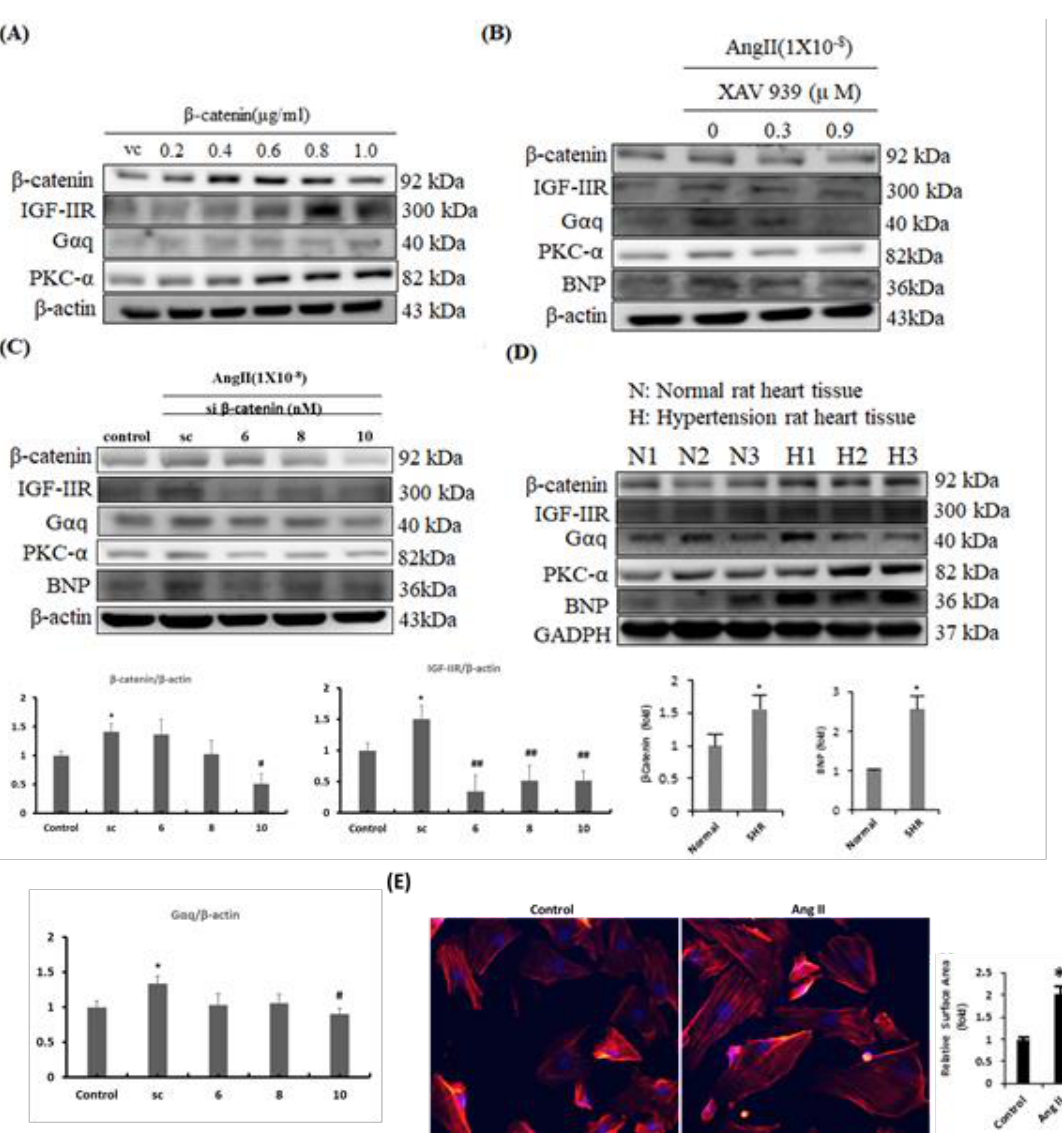
Figure 2. Effect of increased β-catenin and/ or inhibition on IGF-IIR signaling in H9c2 cells and in hypertensive cardiac tissues. ( A ) In H9c2 cells, β–catenin plasmids were transfected in a dose-dependent manner and incubated for 24 h. At the end of the incubation period, cells were harvested and subjected to WB analysis. ( B ) WB analysis showing protein expression of β–catenin, IGF-IIR, Gαq, PKC-α, and BNP upon Ang-II and XAV 939 treatment as done previously. ( C ) H9c2 cells were treated with 100 nM Ang-II and incubated for 24 h. Following 24 h, si-RNA targeting β–catenin was transfected at increasing concentrations (scrambled (sc), 6 nM, 8 nM, 10 nM) for another 24 h. At the end of 48 h, cells were harvested, protein extracted, and analyzed for proteins described above by WB analysis. ( D ) WB analysis showing protein expressions of β–catenin, IGF-IIR and cardiac hypertrophy associated markers in cardiac tissues from SHRs. ( E ) Hypertrophy was assessed in H9c2 cells upon Ang-II treatment for 24 h using Actin-phalloidin staining. n = 3, p * < 0.05, p # < 0.05, p ## < 0.01.